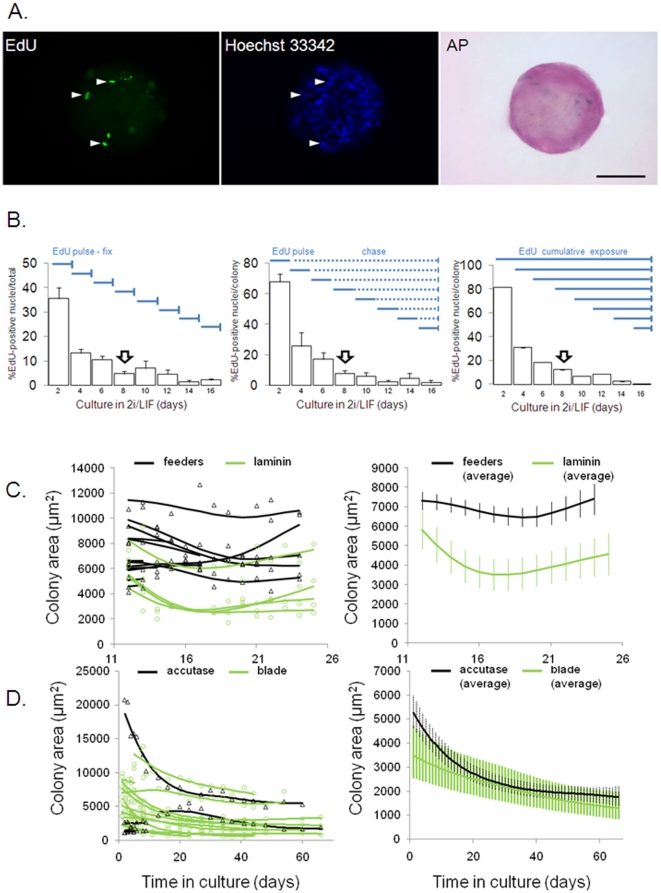
Bovine iPSC-like colonies do not expand in 2i/LIF.(A) Primary AP+ colonies with EdU+ nuclei (arrowheads) after 24 h label. Scale bar  = 50 µm. (B) DNA-synthesis after EdU addition (solid blue horizontal lines). EdU+ nuclei were counted after fixation (solid blue vertical lines). Open arrow indicates first emerging colonies. (C) Prior to passaging, colonies from feeders (black triangles) or laminin (green circles) were tracked. Regression splines were plotted for each colony (left) and averages (right graph). (D) After accutase (black triangles) or blade (green circles) passaging, colonies on laminin were tracked. Regression splines were plotted for each colony (left) and averages (right graph).